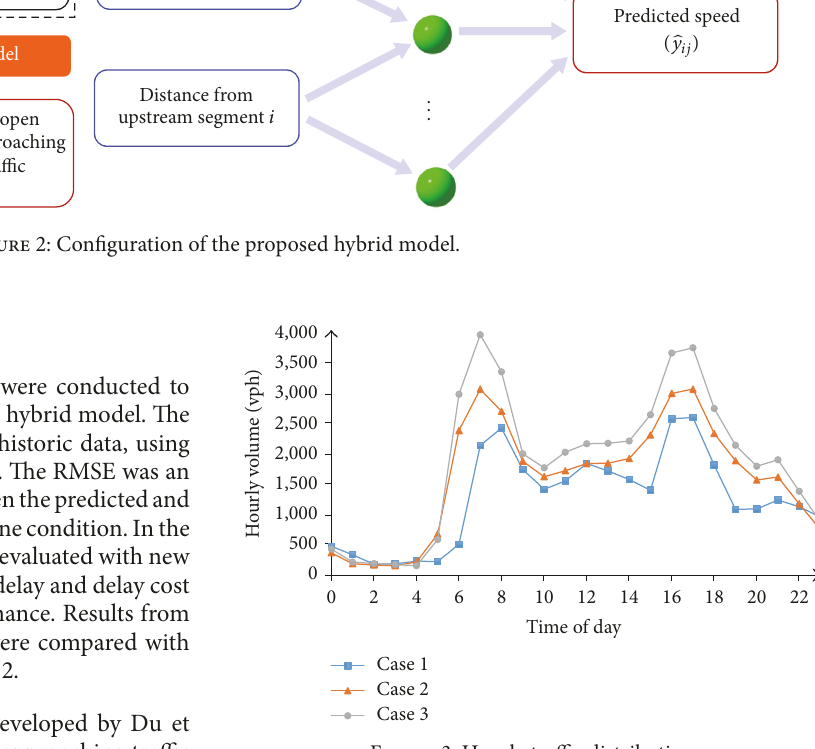
Figure 3: Hourly traffic